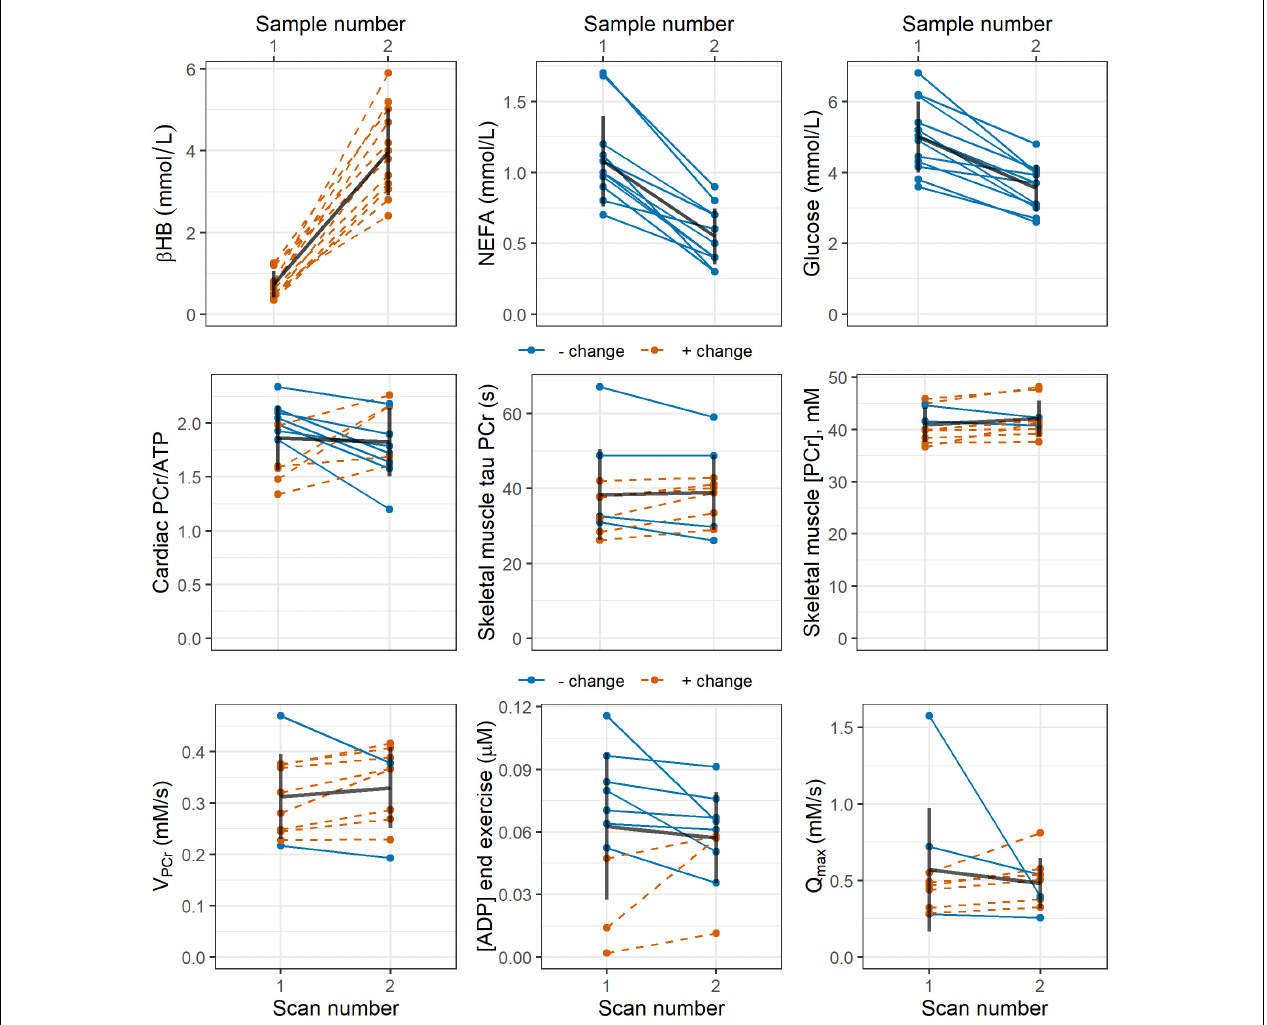
FIGURE 2 | Line plots showing pre- and post-intervention changes in: (top row) blood concentrations of the ketone body D -beta-hydroxybutyrate ( β HB), non-esterified fatty acids (NEFA), and glucose; and (middle and bottom rows) 31 P magnetic resonance spectroscopy measures of cardiac PCr/ATP; and skeletal muscle tau PCr, PCr/ATP, ADP, initial PCr recovery rate V PCr , and maximal rate of oxidative ATP synthesis Q max . Blue, solid lines indicate participants who showed a negative change in the stated parameter, while red, dashed lines represent a positive change. Black lines show the mean change as well as the standard deviation pre- and post-intervention. ADP, adenosine diphosphate; ATP, adenosine triphosphate; PCr,